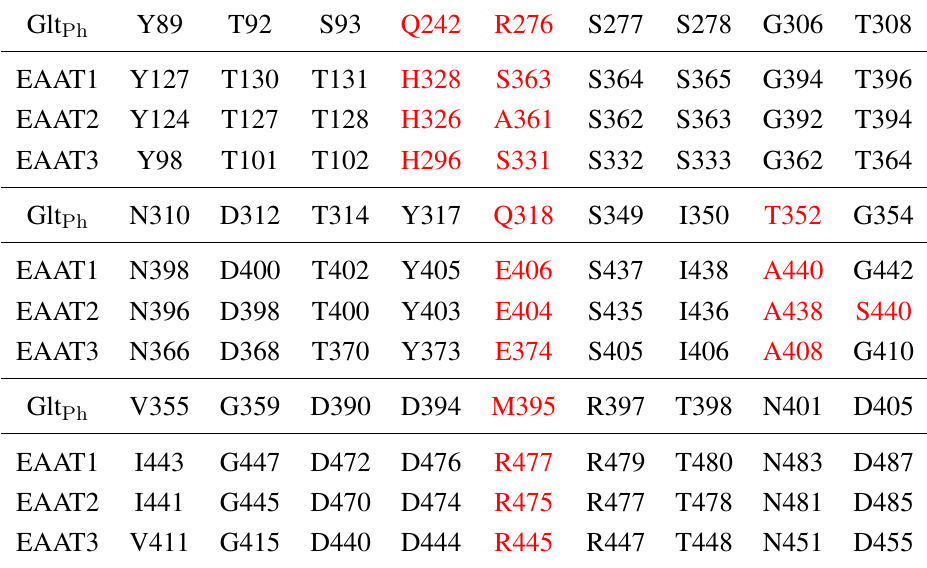
Table 2. Glt residues involved in the coordination of the ligands and their equivalents in Ph excitatory amino acid transporters EAAT1, EAAT2 and EAAT3 (human sequences are used). Residues from the mutagenesis experiments are also included in the table. The residues that are not conserved between Glt and EAATs are indicated with Ph